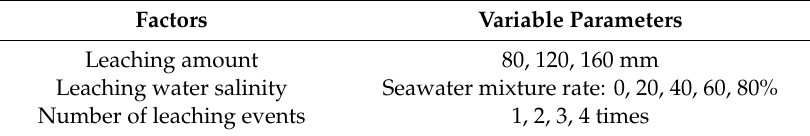
Table 1. Design parameters of leaching practice for model